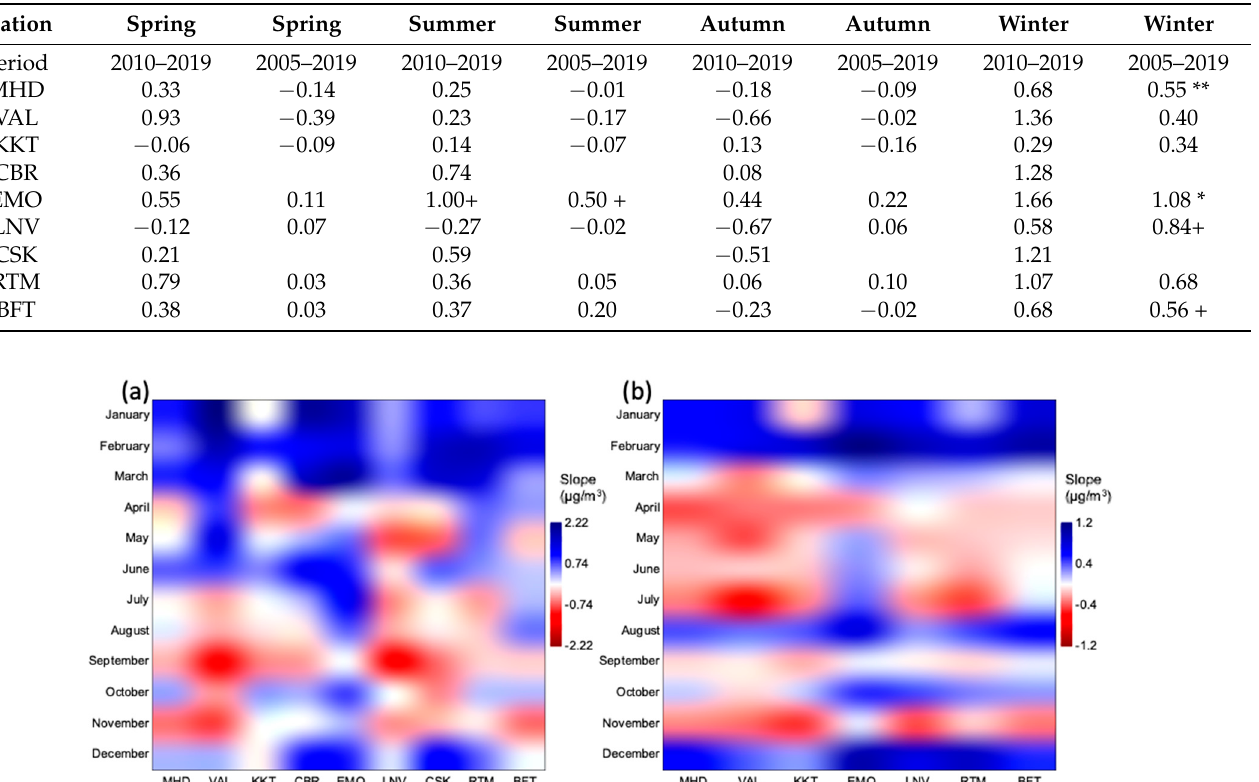
Table 3. Long-term Thiel-Sen slope trends over ten years (2010–2019), and 15-years (2005–2019) of seasonal mean ozone concentration ( µ g/m 3 /year): spring (March, April, May), summer (June, July, August), autumn (September, October, November), and winter (December, January, February). Positive values indicate increases and negative values indicate decreases ( µ g/m 3 per season) in the Theil-Sen slope, and asterisks indicate levels of significance. See Table 1 for station ID codes.